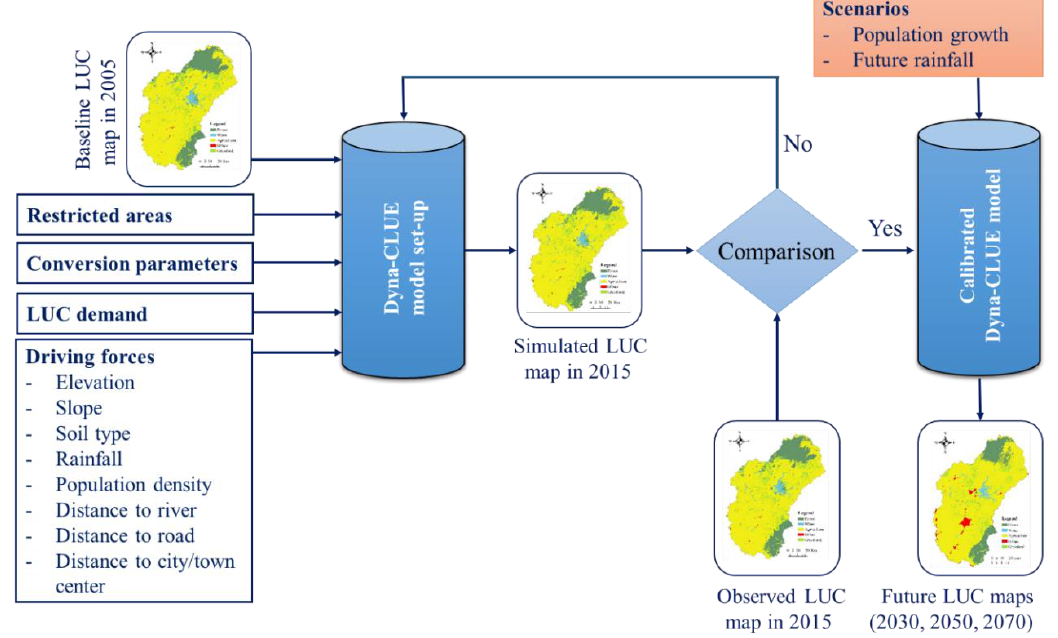
Figure 2. Framework of LUC modelling for the BRB.